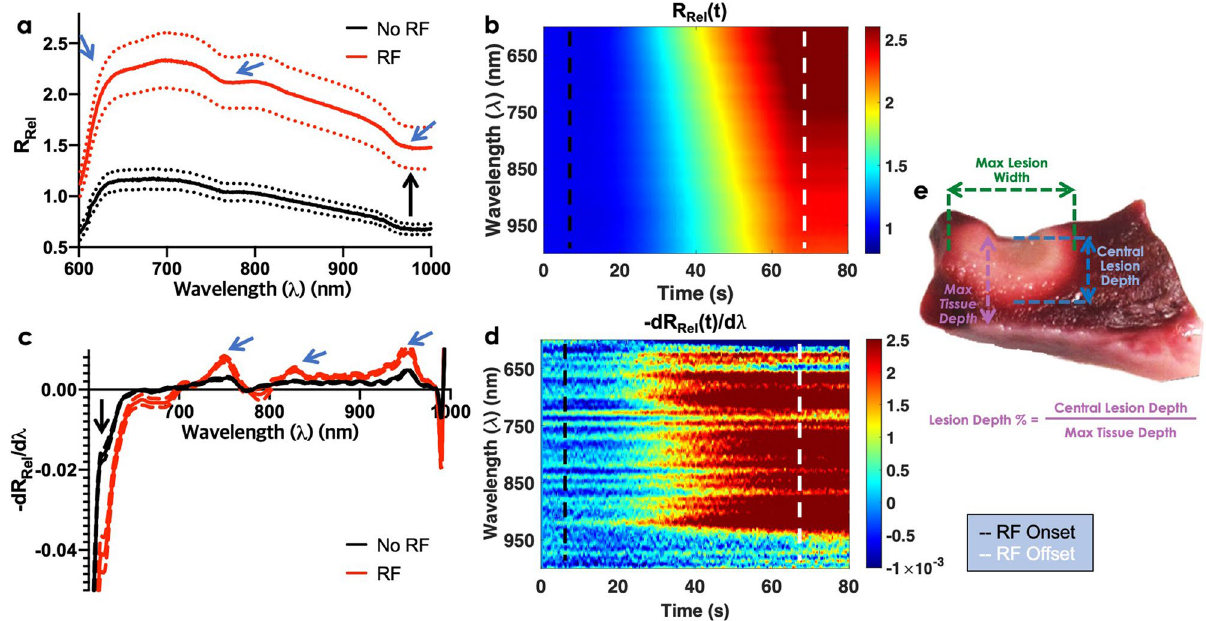
Figure 2. Exemplary real-time monitoring of lesion formation using NIRS. ( a ) Spectral changes in measured relative reflectance ( R Rel ) in response to RF energy (n RF = 44, n noRF = 44). Two main groups of changes were observed: an increase in the mean spectral amplitude or offset (black arrow) and pronounced changes in spectral morphology (blue arrows). Dashed lines (standard deviation). Bold line (mean) ( b ) Temporal changes in measured relative reflectance in response to RF ablation. ( c ) The first derivative of the R Rel curve, normalized at 650 nm, to further emphasize changes in spectral shape. With RF onset, R Rel near 600–700 nm decreased (black arrow), but R Rel in the 740–760 nm and 840–960 nm increased. ( d ) Temporal changes in the first derivative of the R Rel curve. ( e ) Corresponding lesion stained with TTC to reveal the extent of RFA damage. The maximum width and central lesion depth were derived from digitized images as shown. Black dashed lines (RF ablation onset). White dashed lines (RF ablation